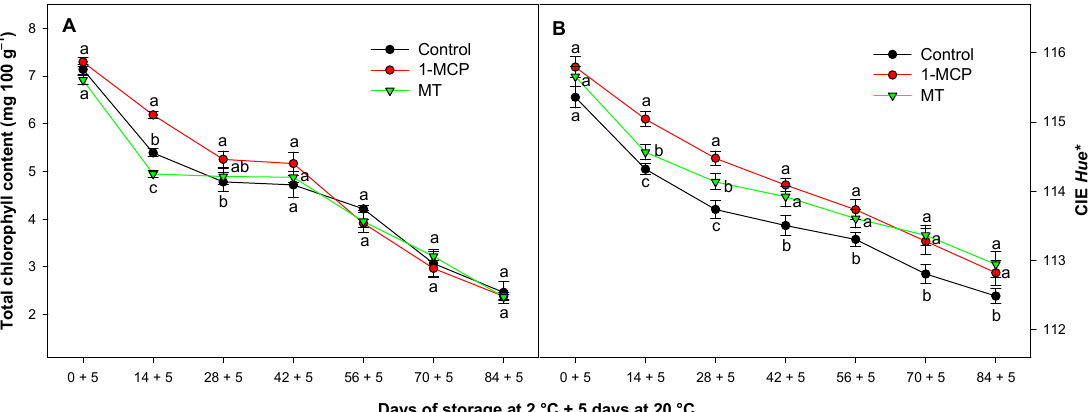
Figure 4. Evolution of total chlorophyll content (mg 100 g − 1 ) ( A ) and CIE Hue * ( B ) of ‘Hayward’ kiwifruit treated with distilled water (Control), 1-MCP at 0.5 µL L − 1 , or melatonin at 0.1 mM (MT) during cold storage plus 5 days at 20 °C. Data are the mean ± SE ( n = 3). Different lowercase letters show significant differences ( p < 0.05) among treatments for each sampling date.